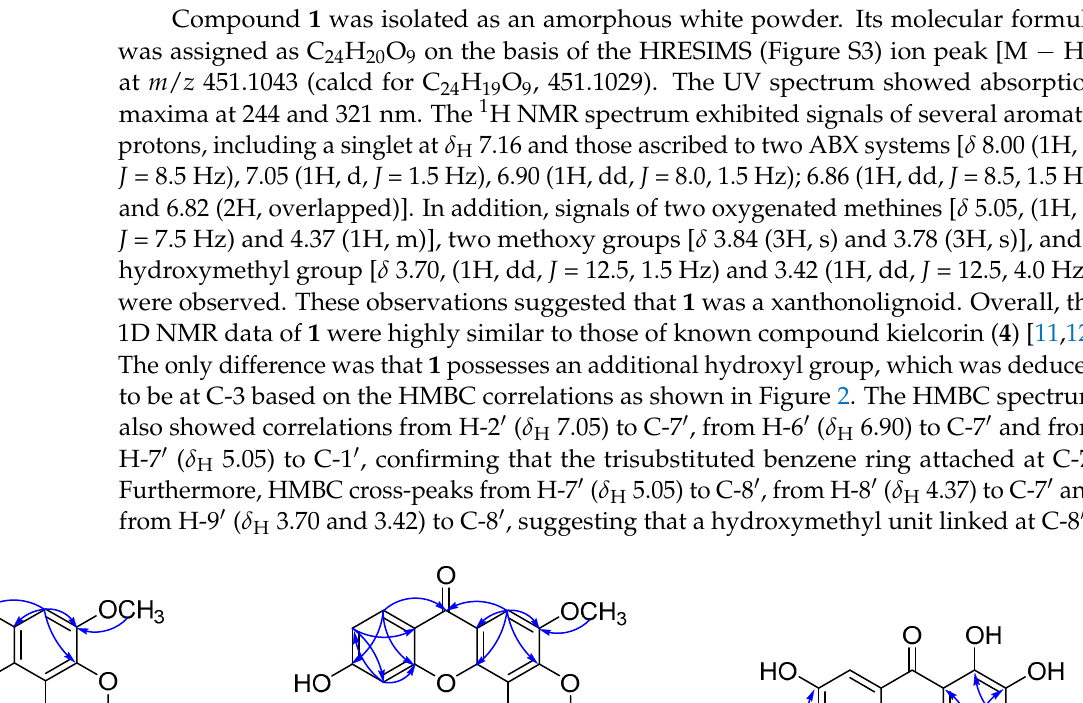
Figure 3. HPLC chromatogram of (±)-6-hydroxy-kielcorin ( 1 ) on a chiral column. Figure 4. Experimental ECD spectra (200 – 400 nm) of 1 in MeOH and the calculated ECD spectra of the model molecules of 1 at the B3LYP/6-311+G(d, p) level. 0.0